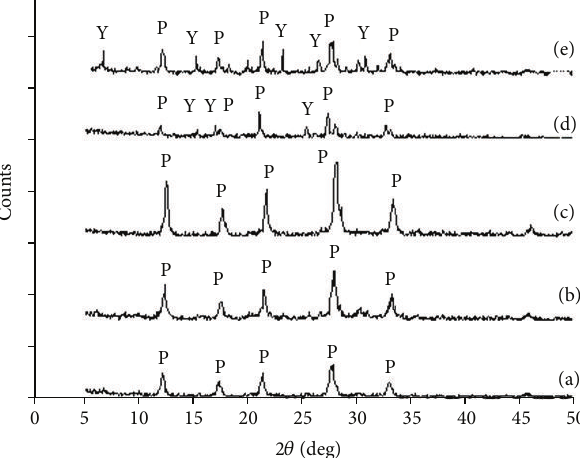
Figure 4: X-ray patterns of synthesized zeolites from initial syn- thetic gel with various Si/Al mole ratios: (a) 3, (b) 5, (c) 15, (d) 30, and (e)